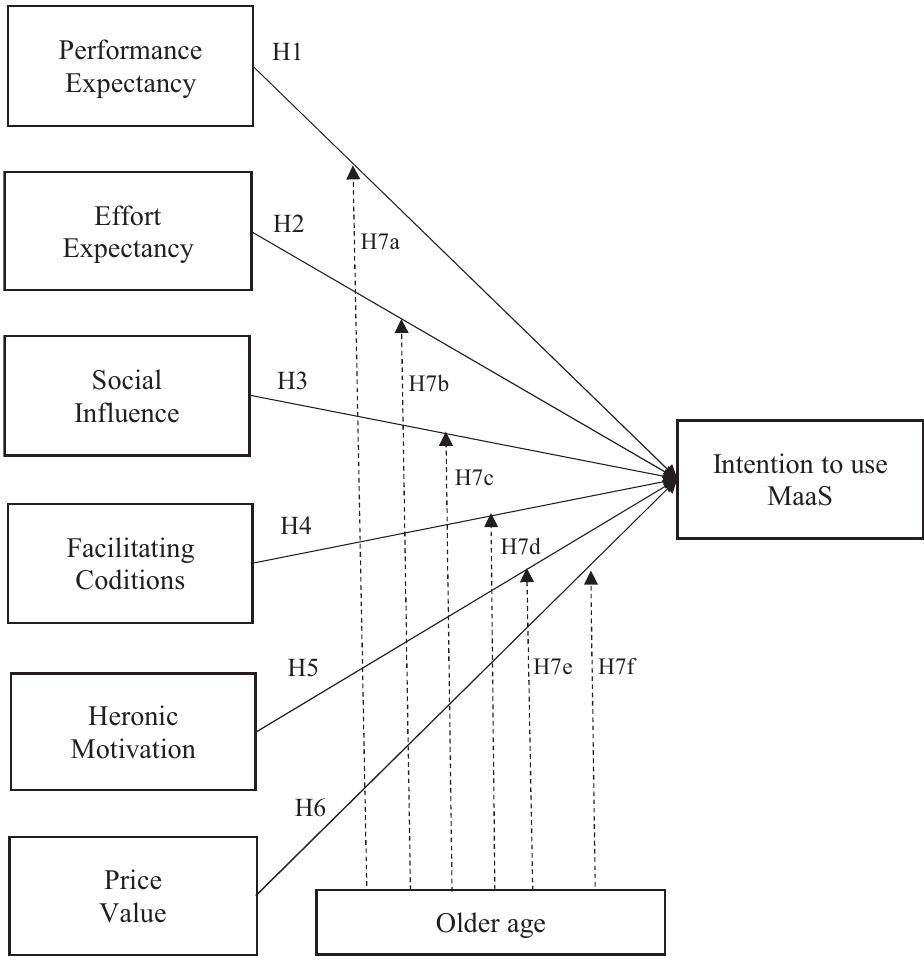
Fig. 1. The research